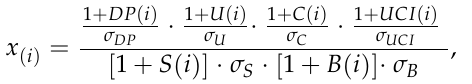
Table 2. Calculation parameters of the comprehensive grade of Chinese fi r spatial structure.